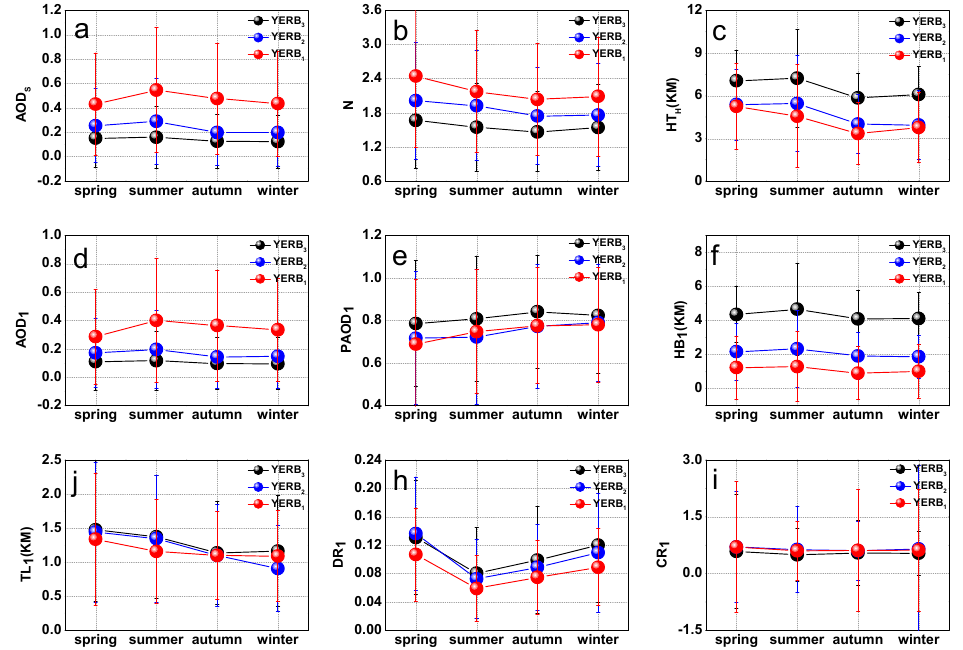
Figure 3. Seasonal variations in optical and physical properties of the lowest aerosol layers in three sub-regions of the YERB: ( a ) AOD S , ( b ) N, ( c ) HT H , ( d ) AOD 1 , ( e ) PAOD 1 , ( f ) HB 1 , ( g ) TL 1 , ( h ) DR 1 and ( i ) CR 1 , from January 2007 to December 2014 (the wavelength is 532 nm).